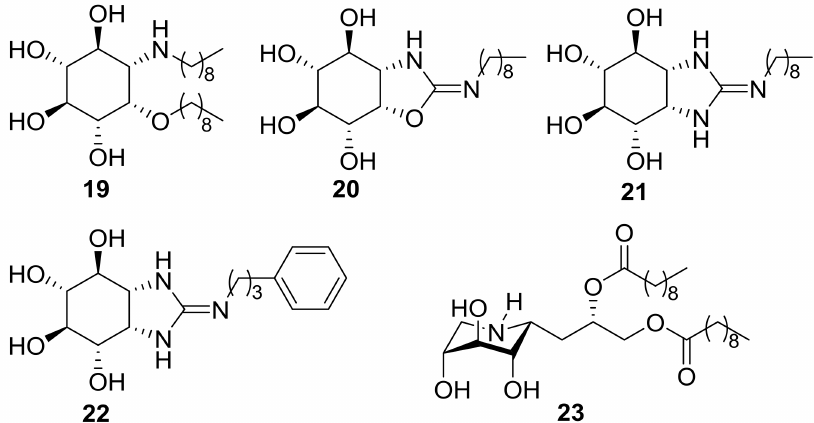
Figure 6. Structures of the pico- and nanomolar mutant GCase chaperones 19 – 23